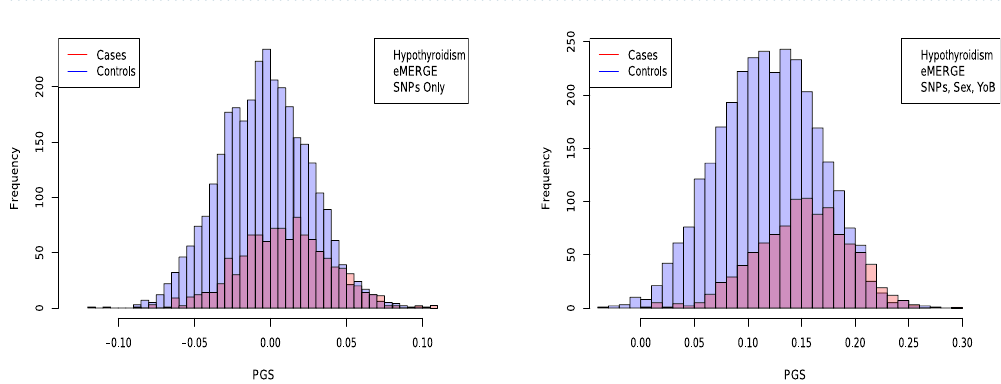
Figure 6. Distribution of PGS score, cases and controls for Resistant Hypertension in the eMERGE dataset using SNPs alone and including sex and age as regressors.